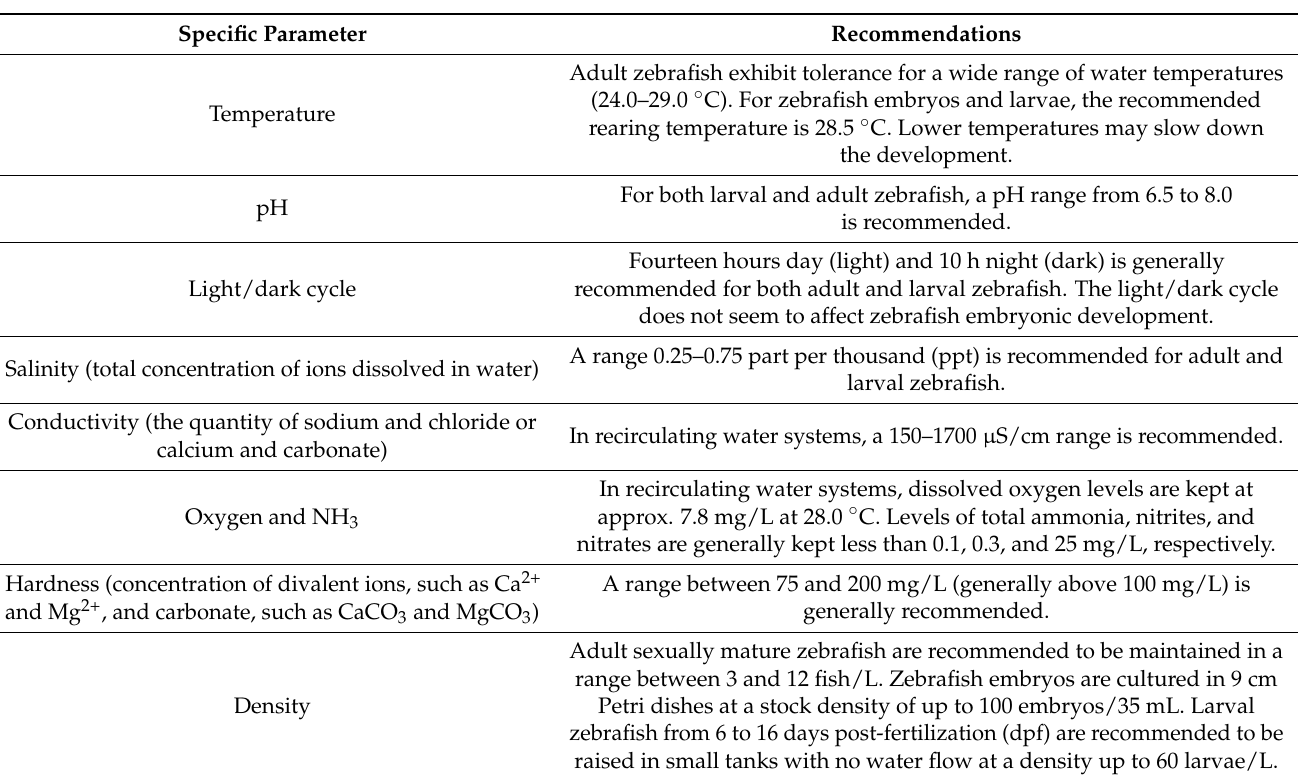
Table 1. Parameters and recommendations for zebrafish